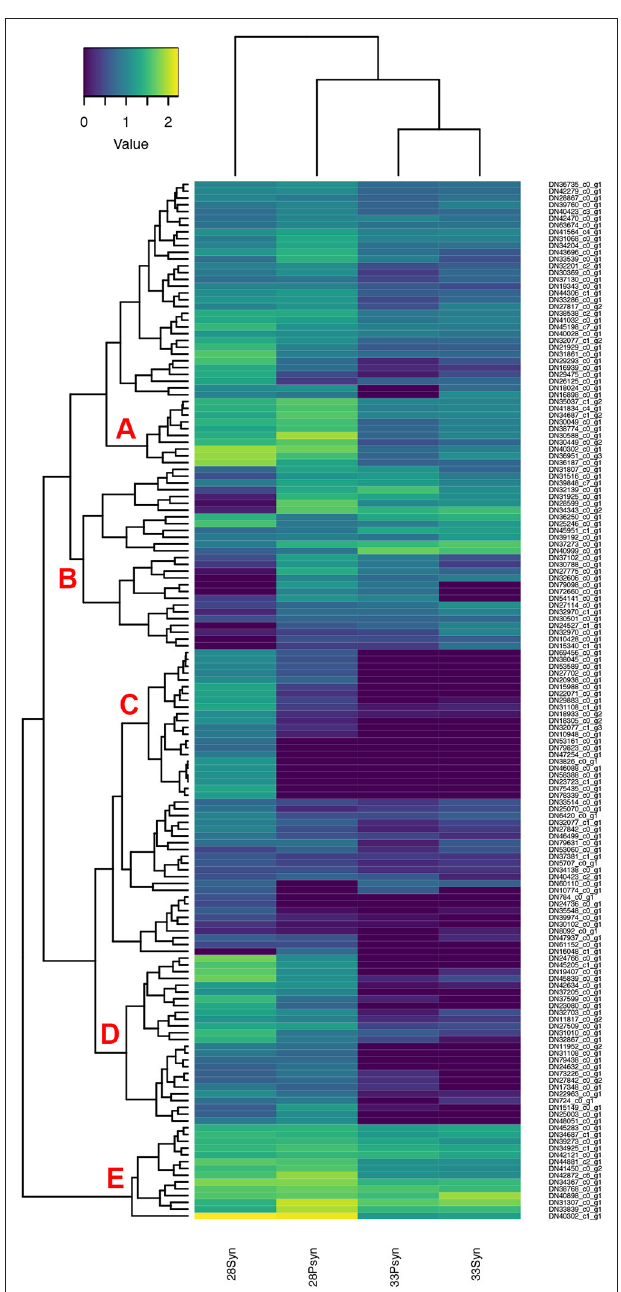
FIGURE 11 | Heatmap of normalized expression for genes annotated to the gene ontology terms “bone resorption” (GO:0045453) and “osteoclast development” (GO:0036035). Although chondrichthyans are thought to lack these processes, several genes are expressed in the four samples.